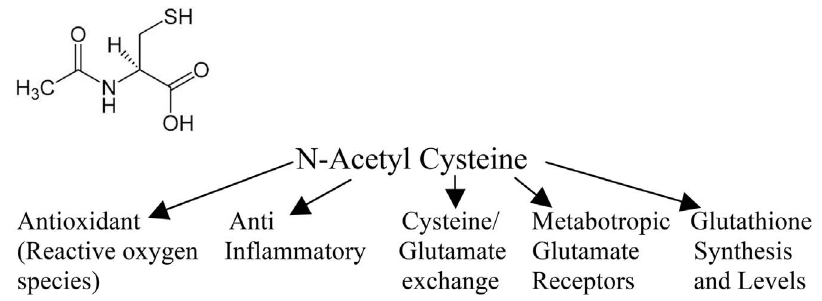
Figure 5. Proposed mechanism of action of N-Acetylcysteine.